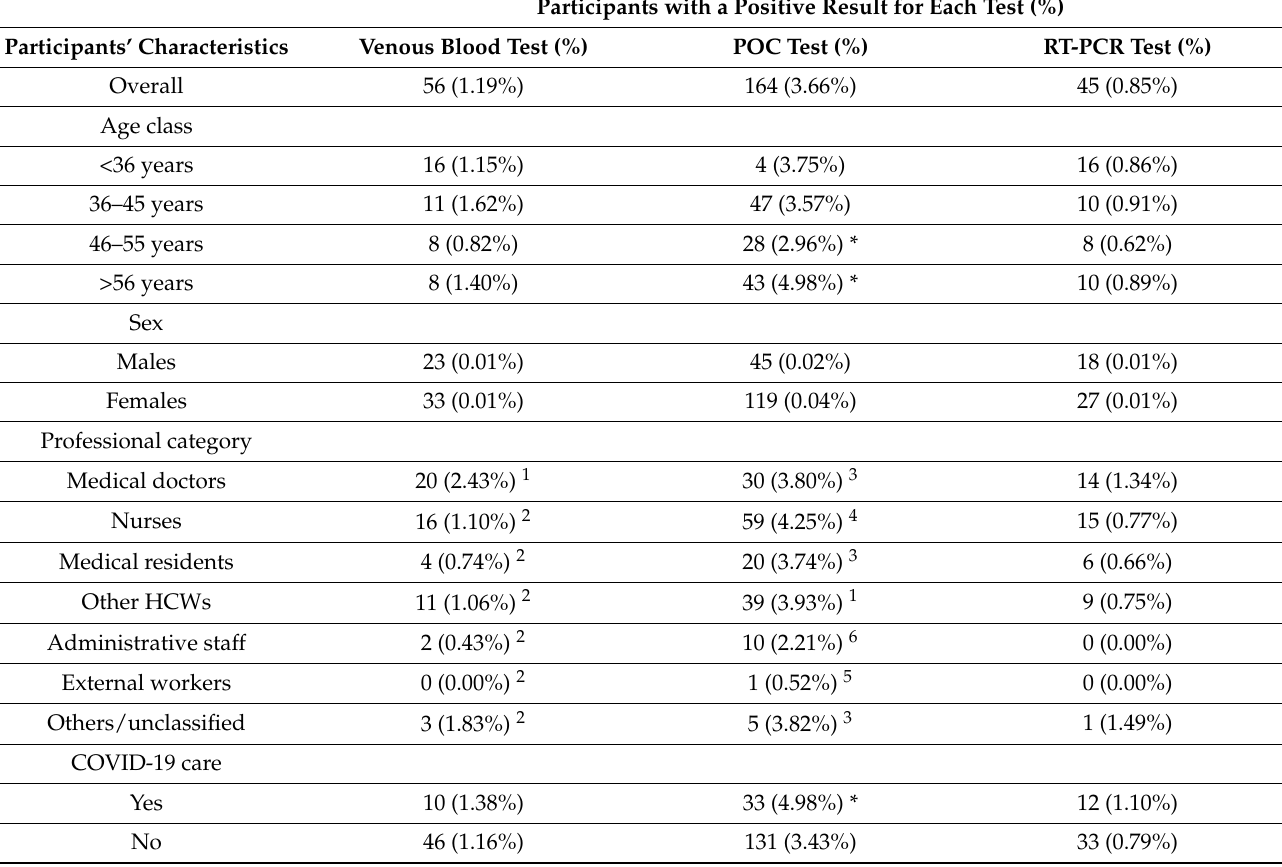
Table 2. Prevalence of severe acute respiratory syndrome coronavirus 2 (SARS-CoV-2) infection based on the three tests and stratified by age, sex, professional category, and direct assistance to COVID-19 patients or not (COVID-19 care, Yes/No).